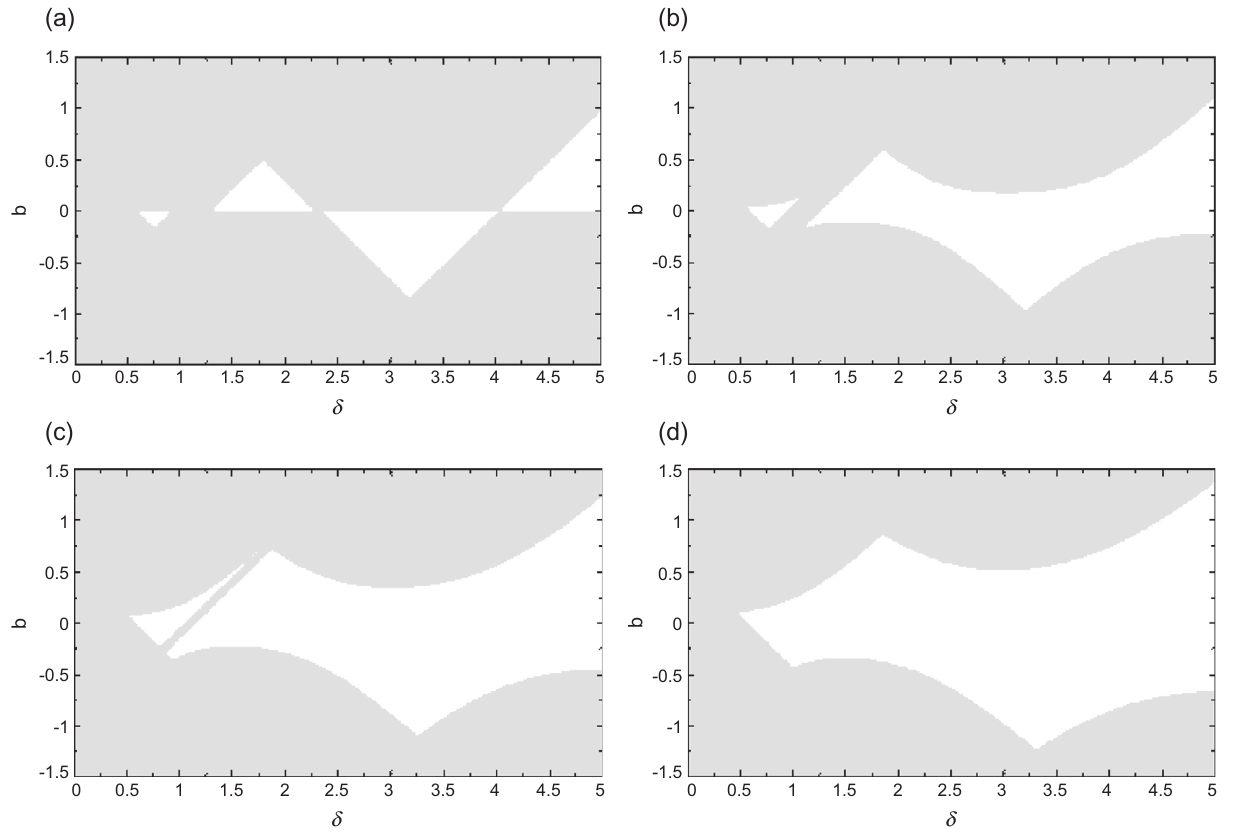
Figure 8. Stability charts of equation (55) from FTRMPA with (cid:2) = 1, x = 1 when (a) damping coefficient j = 0, (b) j = 0.1, (c) j = 0.2 and (d) j = 0.3. The sub-domains of stability are white while those of instability are